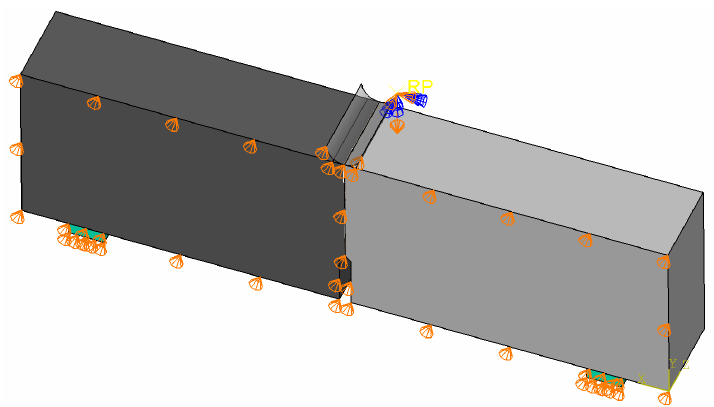
Figure 9. The geometry of the notched beam with assumed boundary conditions.